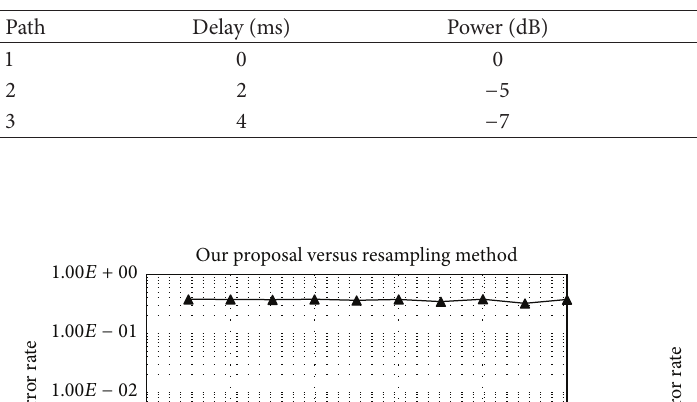
Table 3: Channel for simulation (CNR = 23 dB).